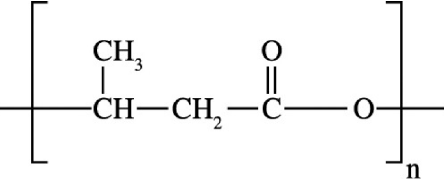
Fig. 1. The chemical structure of the